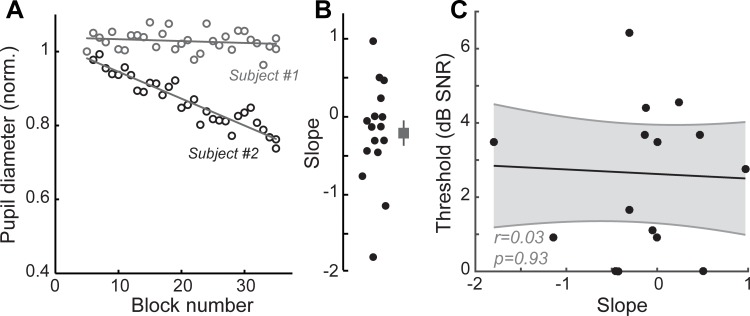
Listening fatigue does not account for performance on the multi-talker digit task.Changes in baseline pupil diameter have been used as an index of listening fatigue (Zekveld et al., 2010; Zekveld et al., 2018). (A) Baseline pupil diameter measured over the course of successive testing blocks in the 0.5 s before trial onset shows minimal changes for one subject and a steady decrease for another. Gray lines show linear fit for each subject. (B) Calculated slope of linear fits for all subjects in the study showing the distributions of changes to baseline pupil diameter. Negative values are suggestive of listening fatigue. (C) No correlations were observed between changes in baseline pupil diameter and performance on the digits comprehension task, suggesting that listening fatigue did not contribute to changes seen in task performance. r = Pearson’s correlation, and shaded area indicates 95% confidence intervals of the regression line (black).Figure 4—figure supplement 1—source data 1.Pupil slope measures as an index of listening fatigue.